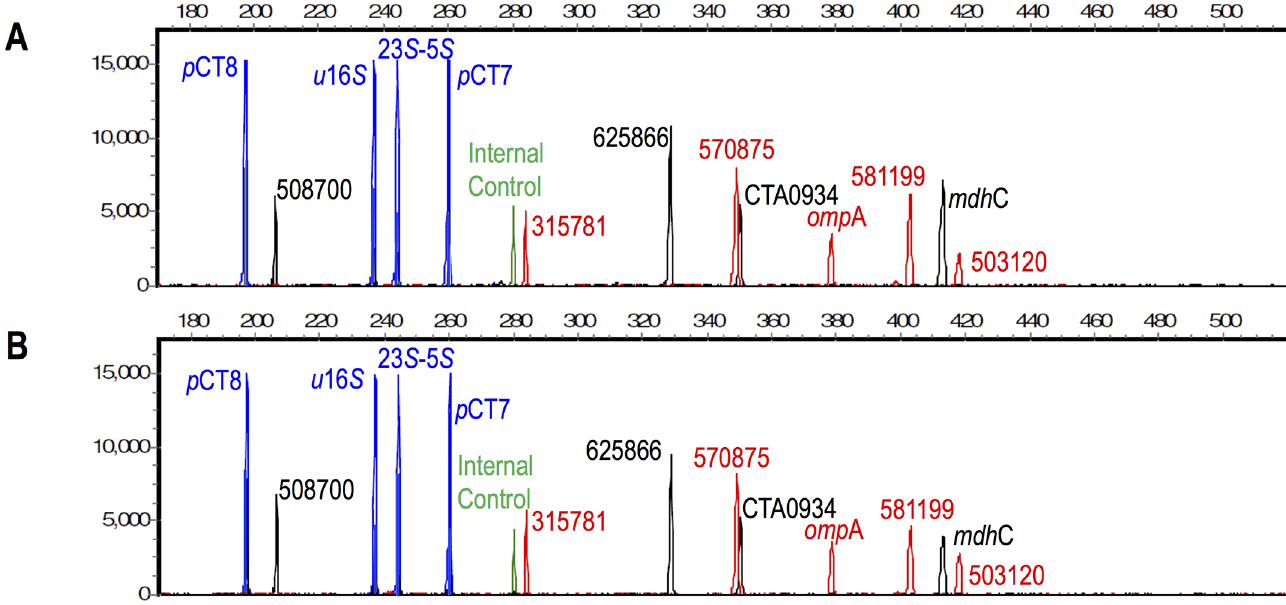
Fig 2. Specificity of the 13-plex Ct amplification assay using L1/440 Ct strain in the presence(A) or absence of Neisseria gonorrhoeae and human genomic DNAs as background DNAs (B). Strain L1/440 was tested at 100 genomicequivalents, and Neisseriagonorrhoeae and human genomicDNAs at 100,000and 10,000 genomicequivalents, respectively. BackgroundDNA had no significanteffect on the characteristic Ct signature based on ampliconand internalcontrol peak heights, and no nonspecific peaks were observed. X-axis: fragment size in bases; Y-axis: RFU.